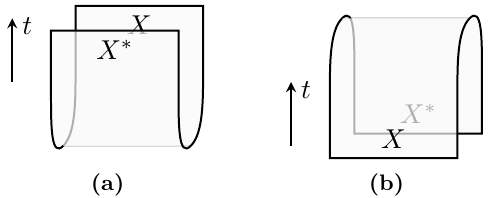
Figure 7. (a): the creation of X and X ∗ is a 1+0D defect in spacetime; (b): the annihilation of X and X ∗ is a 1+0D defect in